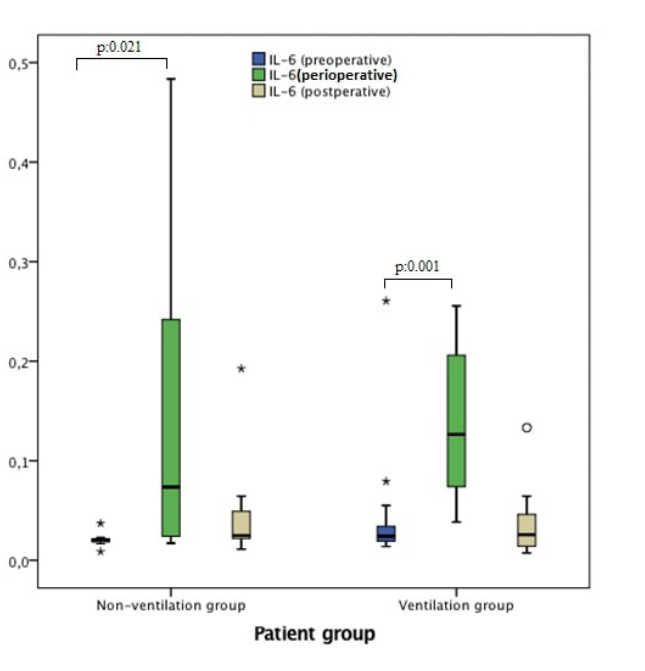
Fig. 4 - TNF-α measurements in preoperative (pre-CPB), perioperative (during CPB) and postoperative (post-CPB)